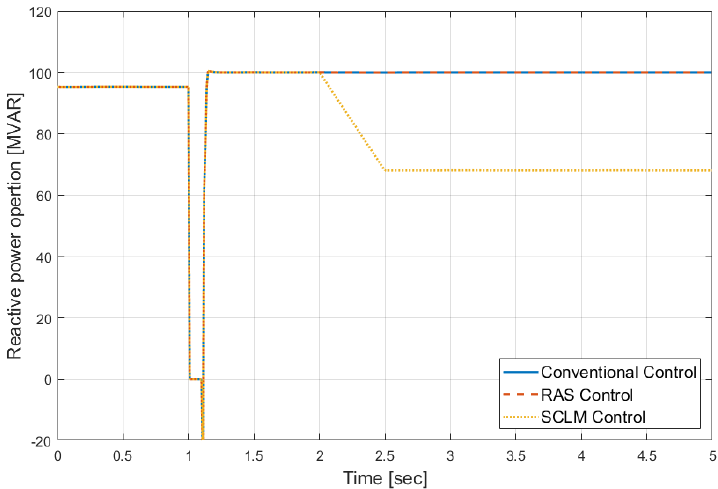
Figure 9. Reactive power operation change in the transformer overload case at the rectifier end.